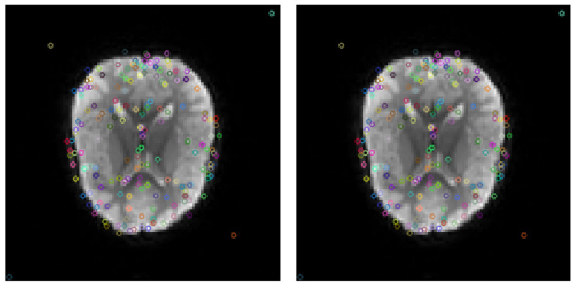
Figure 4. Examples of feature point extraction of t 0 image and t 1